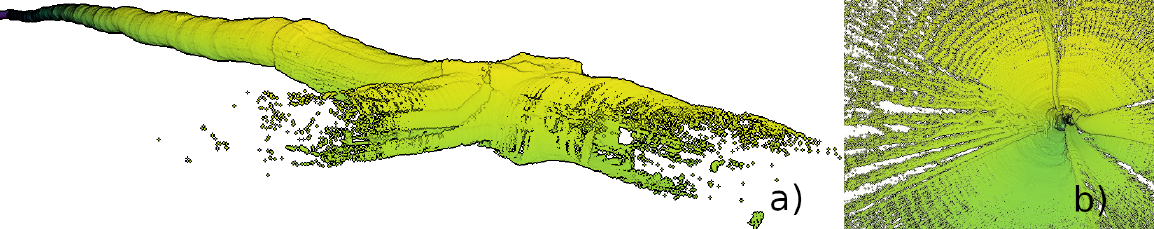
Figure 6. Point cloud of a mine segment. ( a ) Whole cloud (outside view), ( b ) view from inside, along the